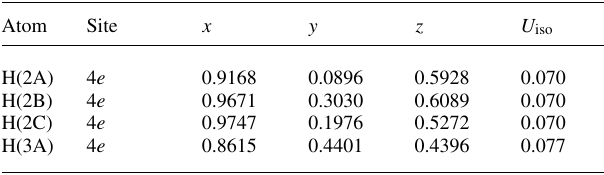
Table 2. Atomic coordinates and displacement parameters (in Å 2 )